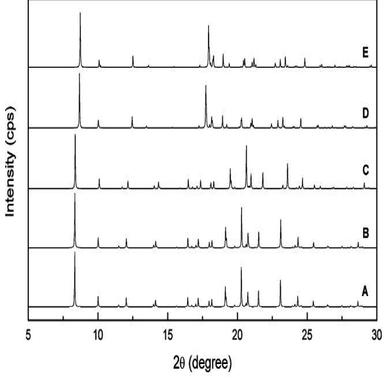
Calculated diffraction patterns for OLZ polymorphs I and II. A) UNOGIN (polymorph I), B) UNOGIN01 (polymorph I), C) UNOGIN03 (polymorph I), D) UNOGIN02 (polymorph II and E) UNOGIN04 (polymorph II at low temperature).